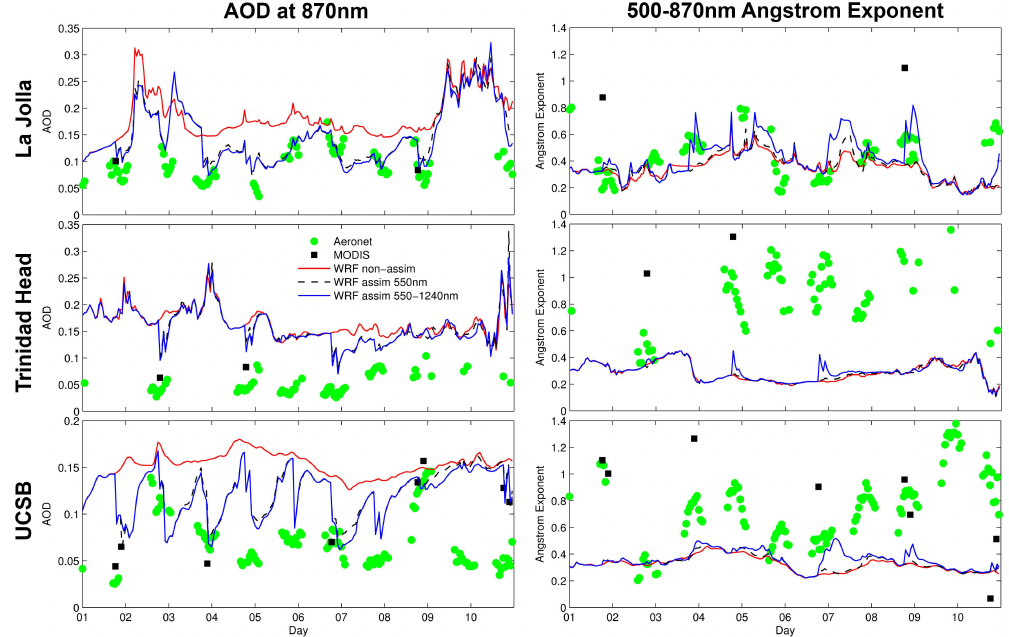
Fig. 13. As Fig. 6 but for of 870nm AOD and 500–870nm Ångström exponent from coastal AERONET sites. The three models shown are the non-assimilated, and forecasts assimilating MODIS 550nm only and wavelengths from 550nm to 1240nm. MODIS ocean retrieval (870nm AOD and 550–870nm Ångström exponent) is shown when data is within 0.2 degree of the site. See Fig. 1 for AERONET sites